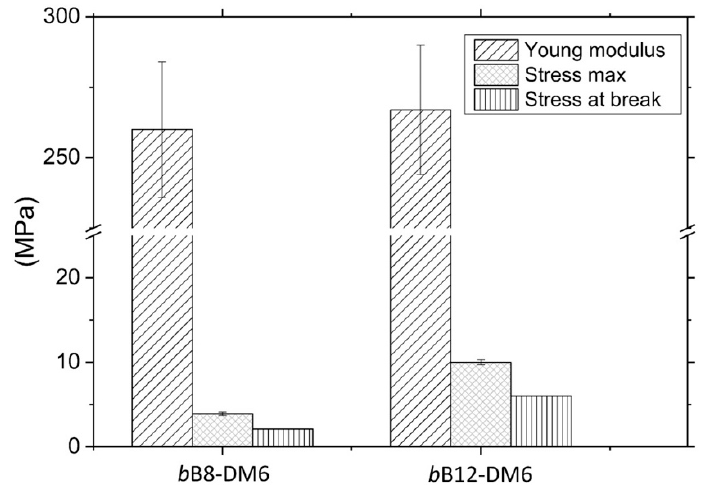
Figure 6. Graphical representation of b B12-DM6 and b B8-DM6 tensile properties. Table 8. Tensile data of b B8-DM6 and b B12-DM6. Young Modulus Sample Thickness (mm) Stress Max (MPa) (MPa)